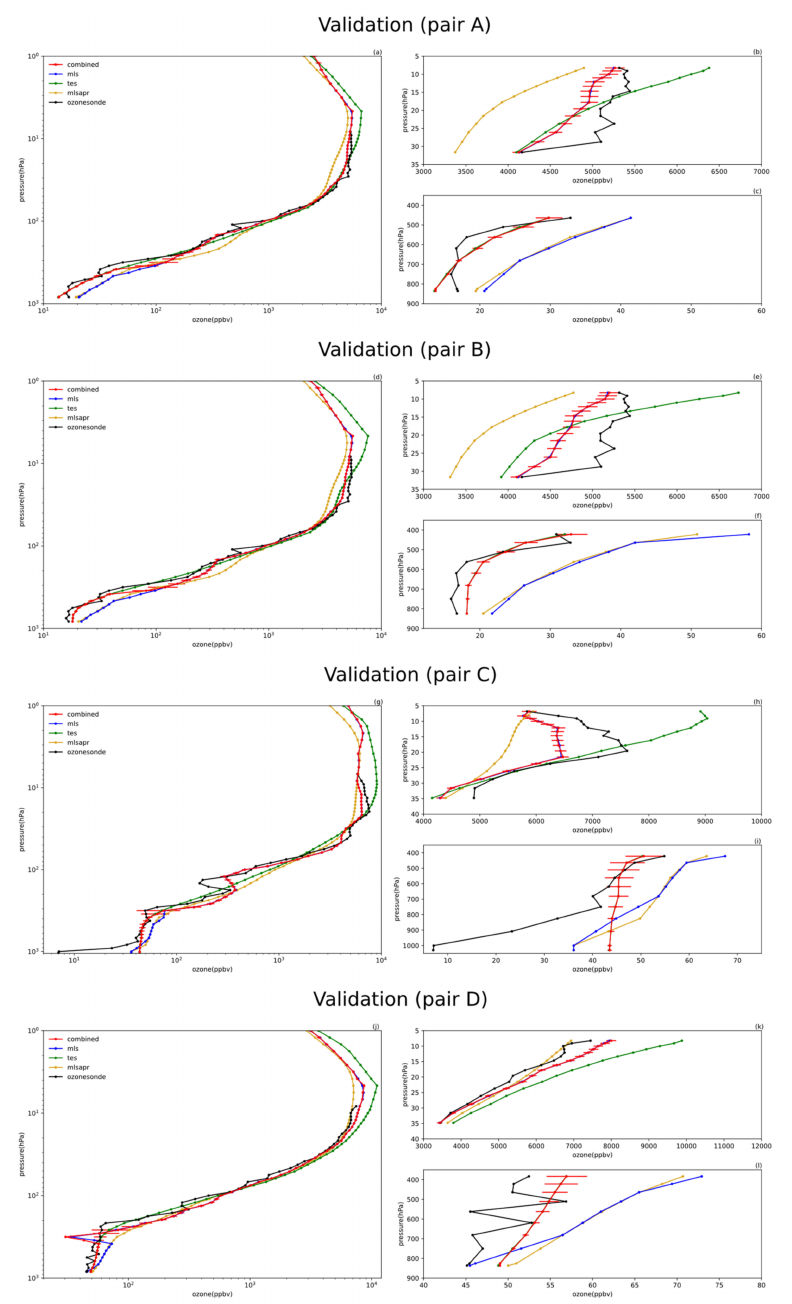
Figure 6. Comparison among vertical profiles for validation for ( a ) pair A, ( d ) pair B, ( g ) pair B, and ( j ) pair B: combined profile with error bars (red), MLS profile (blue), TES profile (green), MLS a priori profile (yellow), and ozonesonde profile (black). ( b ) The partial enlargement of ( a ) between 35 hPa and 5 hPa. ( c ) The partial enlargement of ( a ) between 900 hPa and 350 hPa. ( e ) Similar as ( b ), but for pair B. ( f ) Similar as ( c ), but for pair B. ( h ) The partial enlargement of ( g ) between 40 hPa and 5 hPa. ( i ) The partial enlargement of ( g ) between 1050 hPa and 350 hPa. ( k ) The partial enlargement of ( j ) between 40 hPa and 5 hPa. ( l ) The partial enlargement of ( j ) between 900 hPa and 350